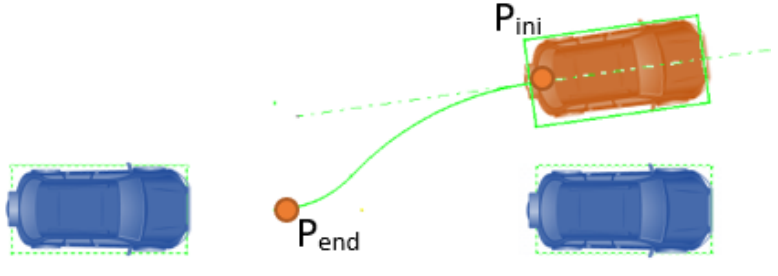
Figure 9. Parallel parking trajectory generation